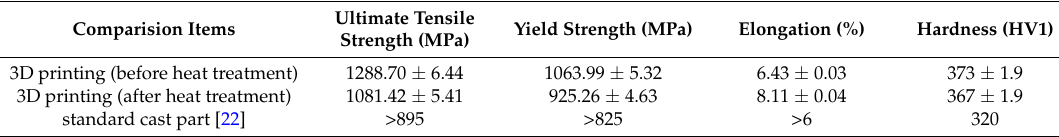
Table 3. Mechanical properties of 3D printed part.